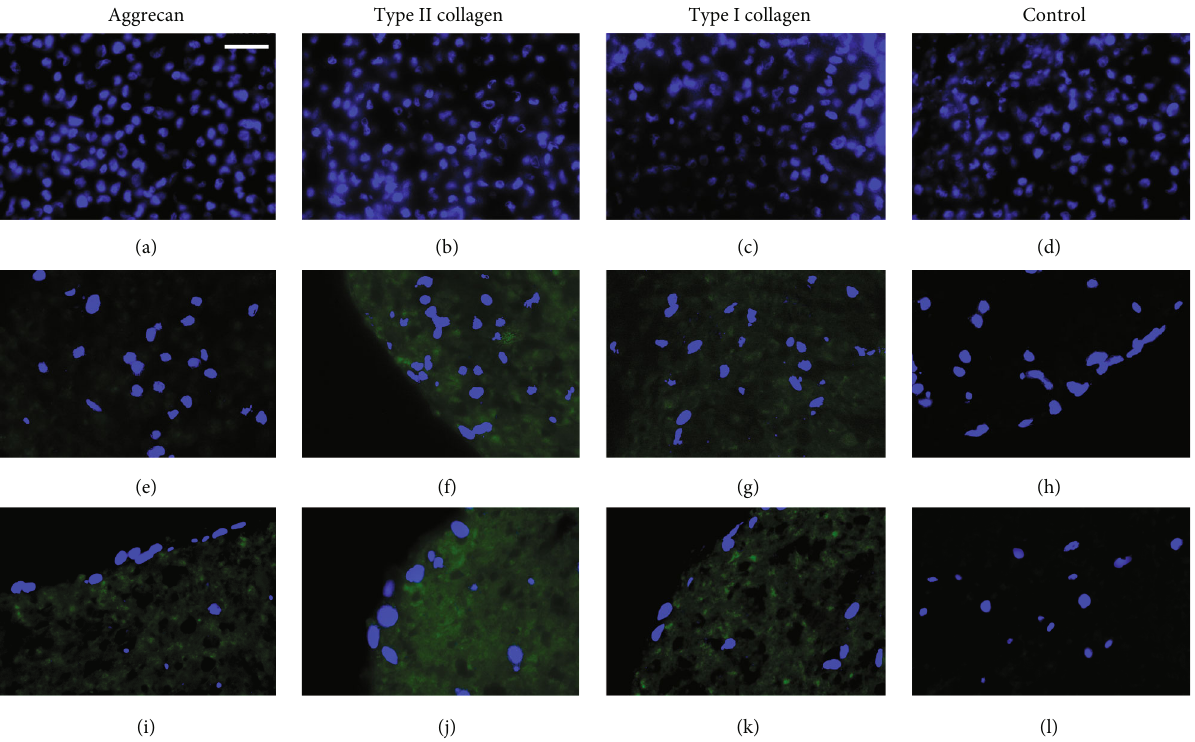
Figure 4: Immuno fl uorescence microphotographs of hDPSCs microtissue-cultures with proliferation medium for (a – d) 2 weeks, (e – h) 4 weeks, and (i – l) 6 weeks. Control samples were incubated only with the secondary antibody. Cellular nuclei are observed in blue, and the presence of the di ff erent speci fi c macromolecules was analysed in green. To facilitate the visualization of the fl uorescence signal, green channel parameters of some images were modi fi ed by PhotoShop: (e, g) saturation + 100 % and luminosity + 50 % and (f) saturation + 100 % and luminosity + 25 % . Scale bar = 25 μ m